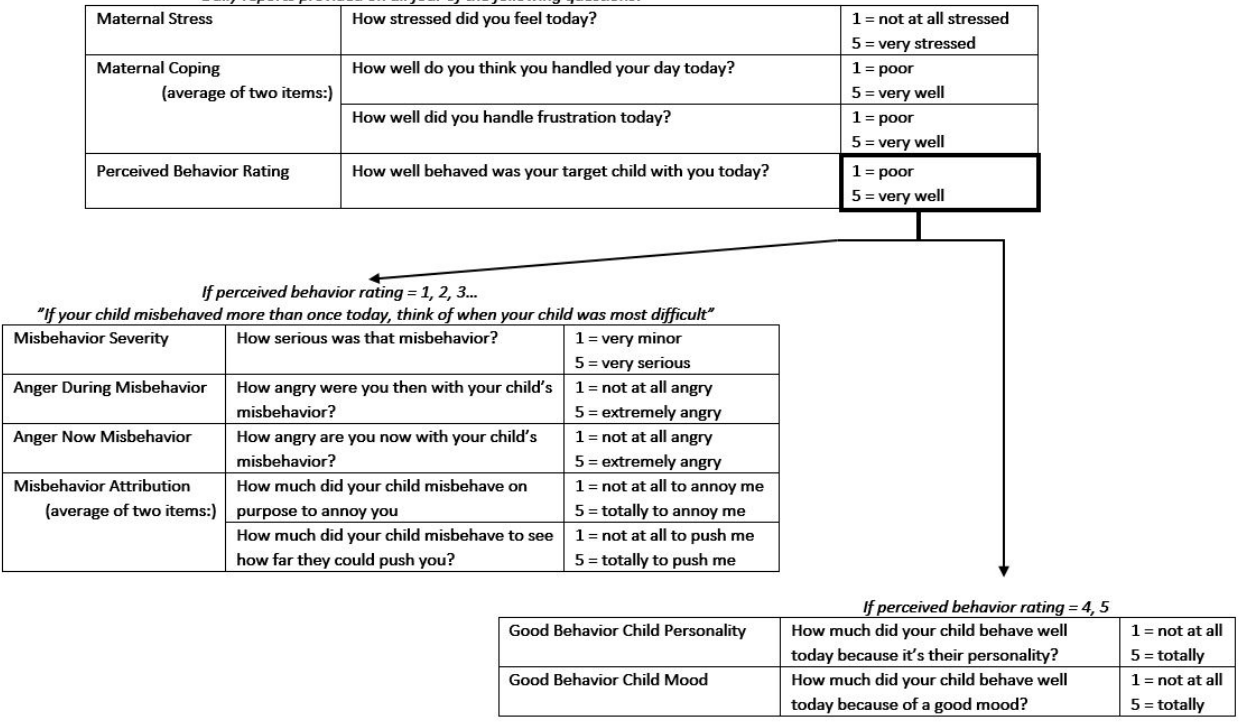
Figure 1. Items presented to mothers in a branching pattern.